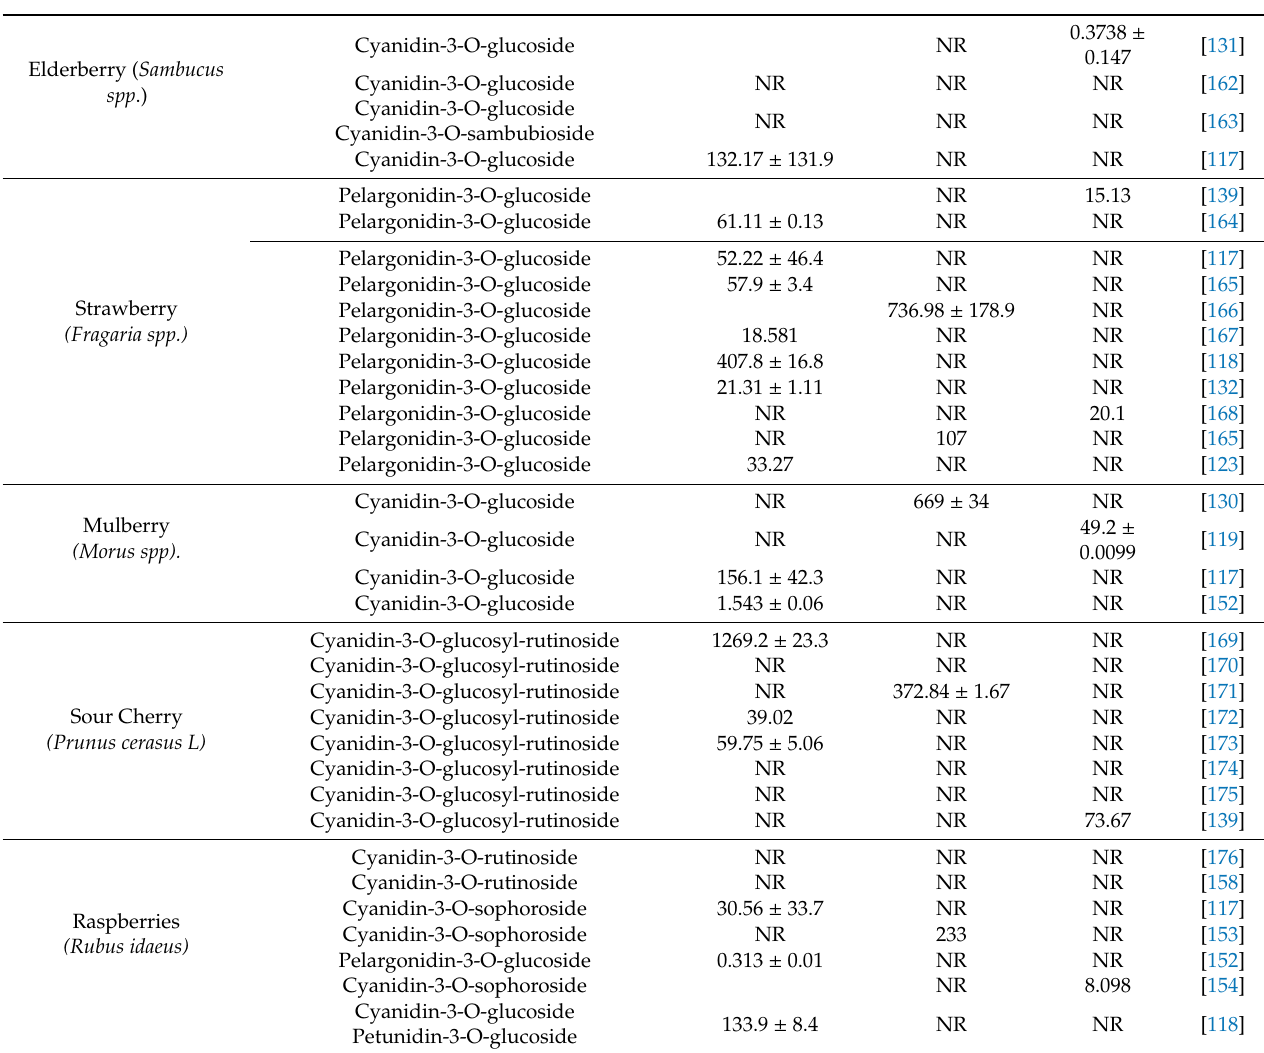
Elderberry ( Sambucus spp